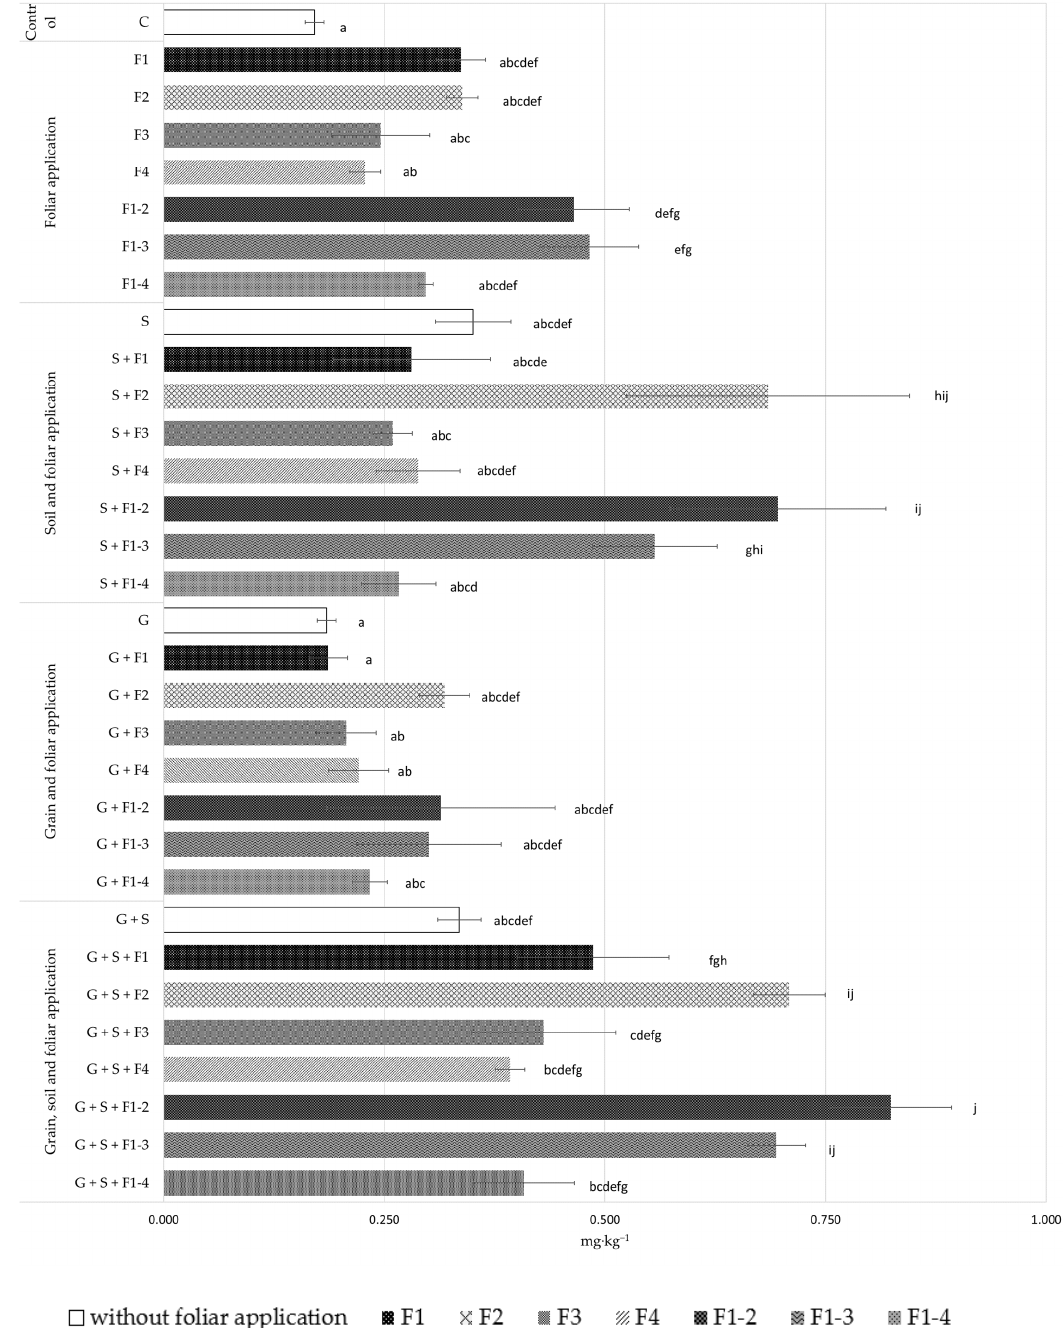
Figure 3. Grain Se depending on fertilization. Results show means and standard errors ( n = 3). a, b, c—means followed by the same letter are not significantly different from one another based on Tukey’s test at p ≤